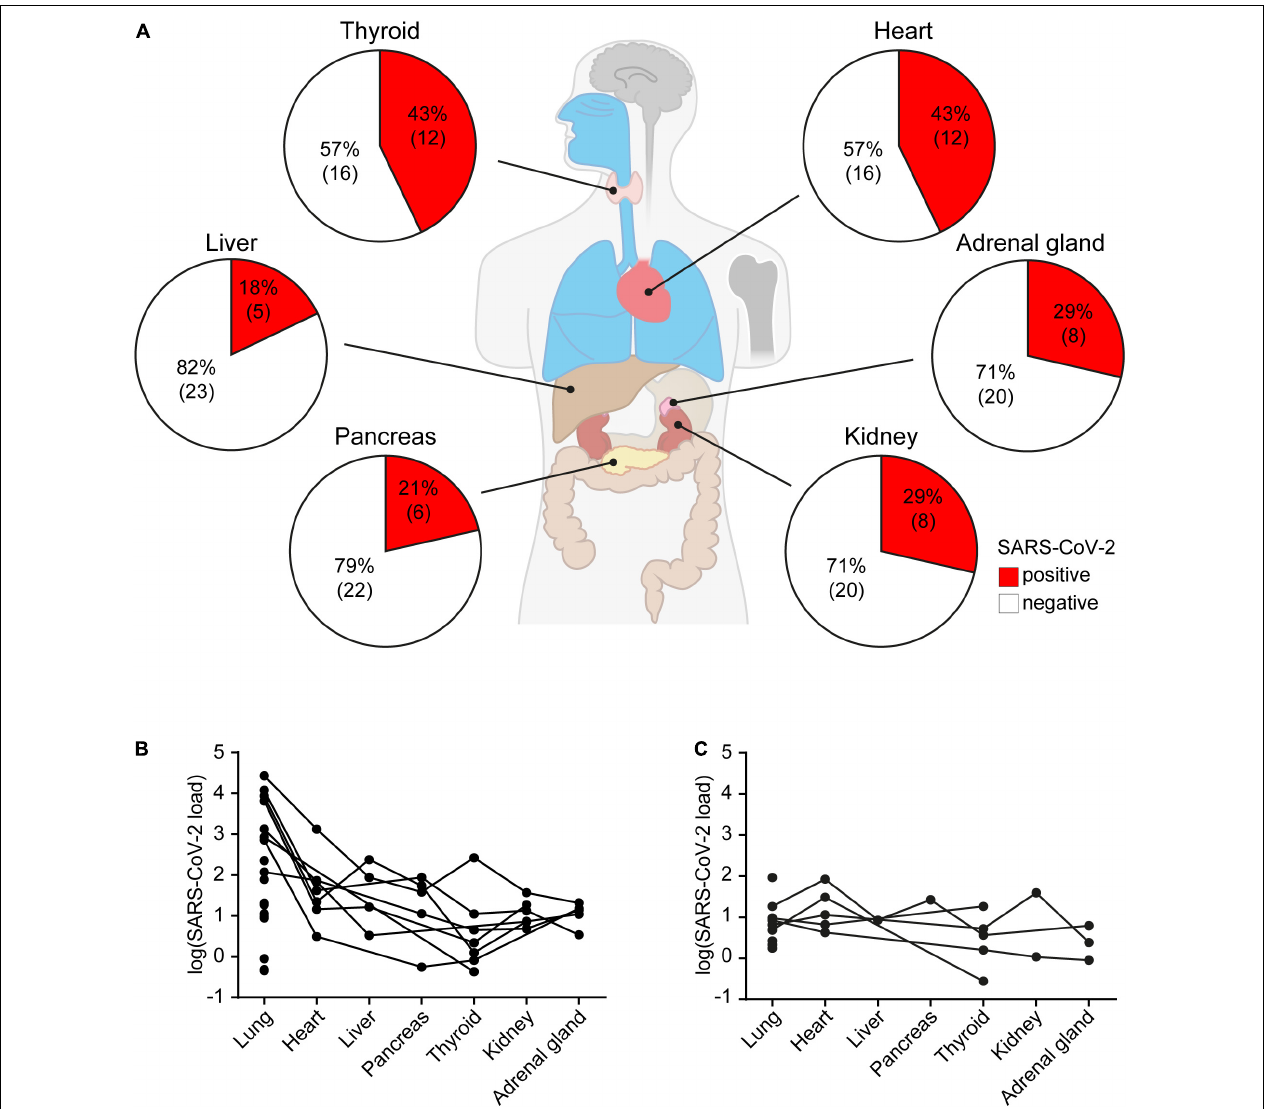
FIGURE 3 | SARS-CoV-2 organ distribution in all 28 autopsy cases with SARS-CoV-2 positive lung tissues. (A) Percentage of SARS-CoV-2 positive heart, adrenal gland, kidney, pancreas, liver and thyroid samples of all SARS-CoV-2 infected patients. Viral load in organs of (B) patients with a clinically known COVID-19 diagnosis ( n = 18), and (C) unexpected SARS-CoV-2 positive cases ( n = 10). Data represent median of three technical replicates, lines connect data from the same individual. Median viral loads of SARS-CoV-2 in different organs are listed in Supplementary Table 4